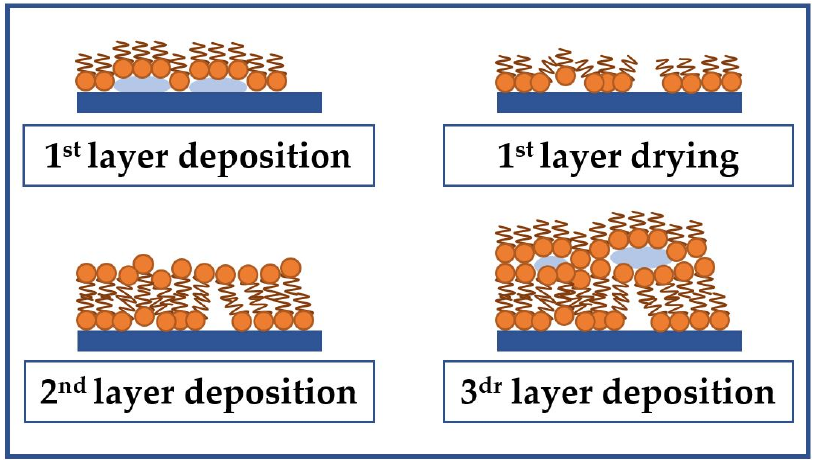
Figure 15. Schematic presentation of the formation of an LB film of stearic acid with a developed morphology on the surface of a hydrophilic substrate.